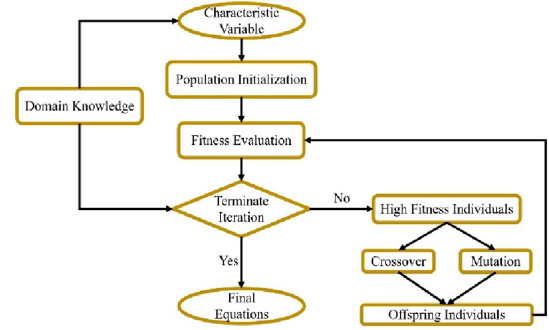
Figure 3 Procedure of domain knowledge-guided SR